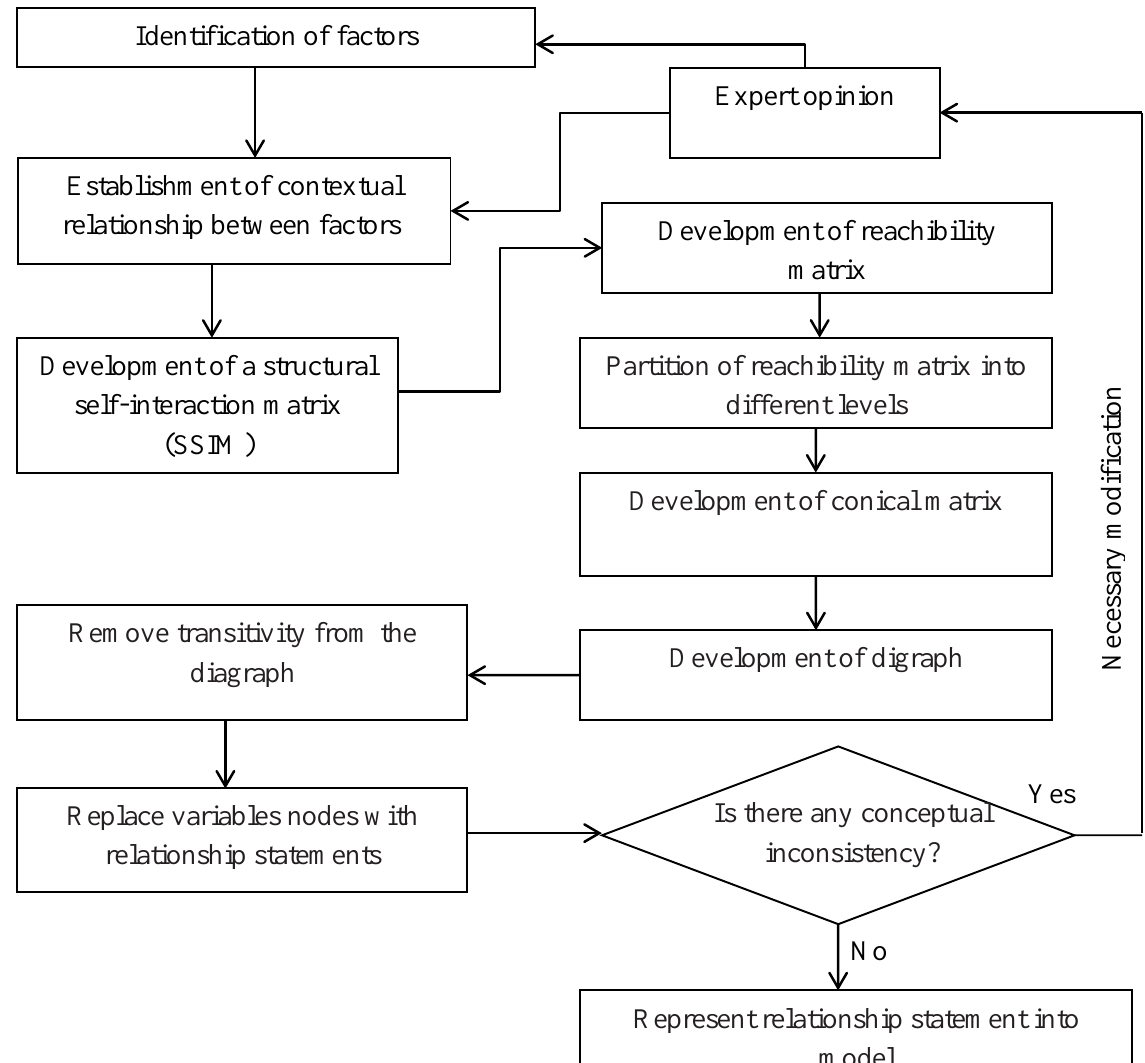
Fig. 2. Flow diagram for preparing ISM model (Raj & Attri, 2011; Attri et al.,